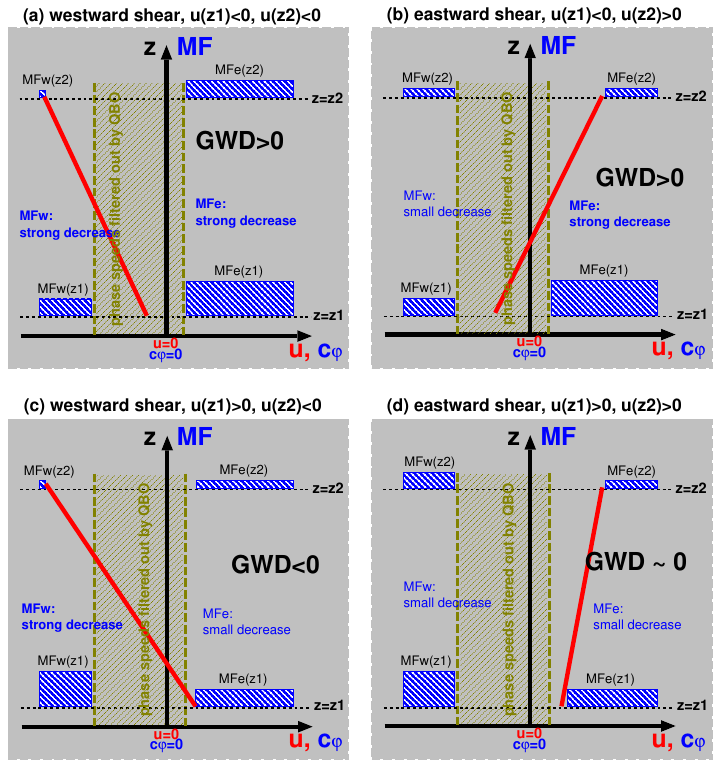
Figure 4. Schematic illustration of four characteristic cases how gravity wave drag contributions in the SAO momentum budget are generated. Two altitude levels are considered. The level z 1 is located below the SAO-related wind shear, and the level z 2 above it. The red lines indicate simplified vertical profiles of the zonal background wind u . The blue hatched boxes indicate the amount of gravity wave momentum flux at the two levels with MFw (MFe) the momentum flux for westward (eastward) ground-based phase speed C ϕ . It is assumed that there is no momentum flux at ground-based phase speeds located between the green dashed vertical lines, because this phase speed range has been removed through critical-level filtering by the QBO at altitudes z < z 1 . The four cases are (a) westward vertical shear of the zonal wind, u(z 1 ) < 0 and u(z 2 ) < 0; (b) eastward wind shear, u(z 1 ) < 0 and u(z 2 ) > 0; (c) westward wind shear, u(z 1 ) > 0 and u(z 2 ) < 0; and (d) eastward wind shear, u(z 1 ) > 0 and u(z 2 ) >